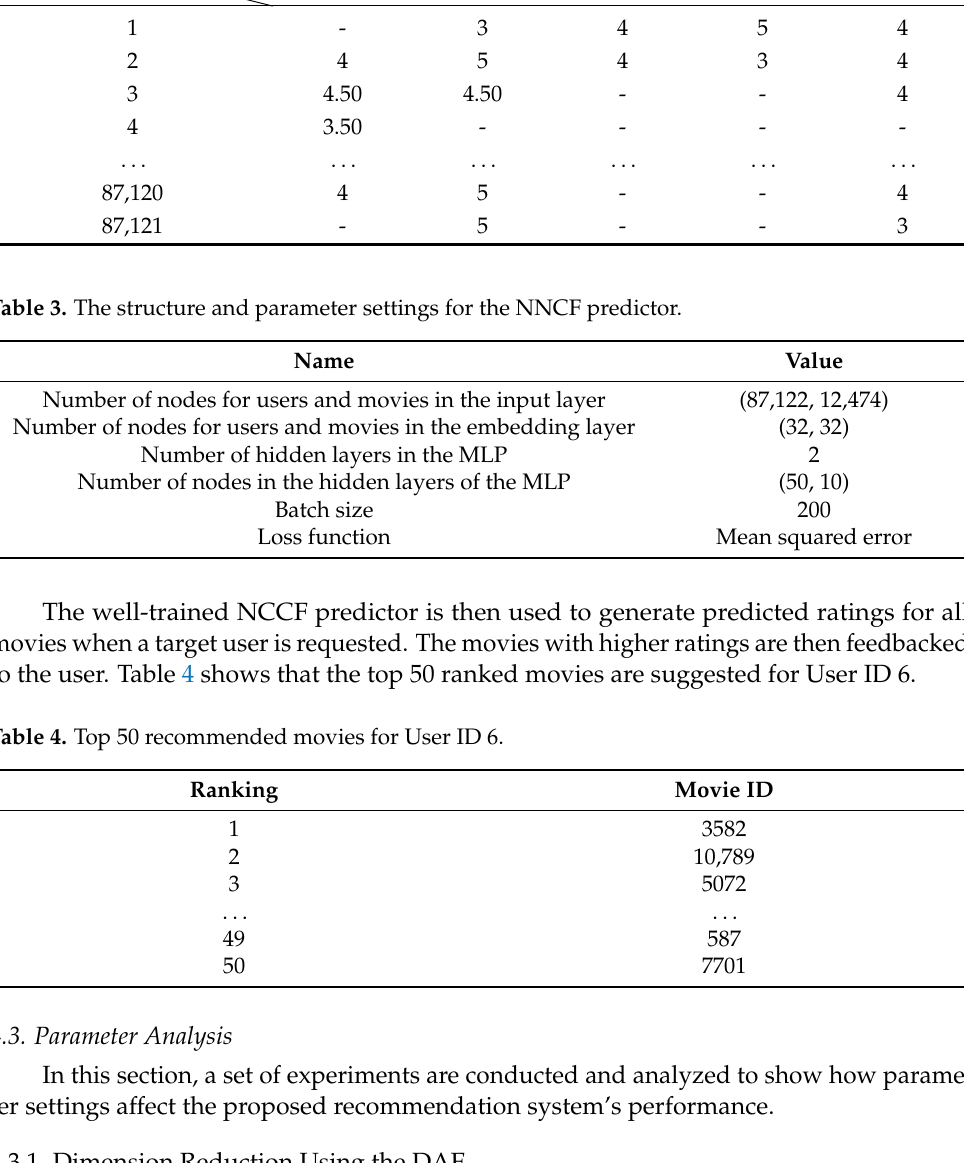
Table 2. The predicted ratings for five example CS movies.